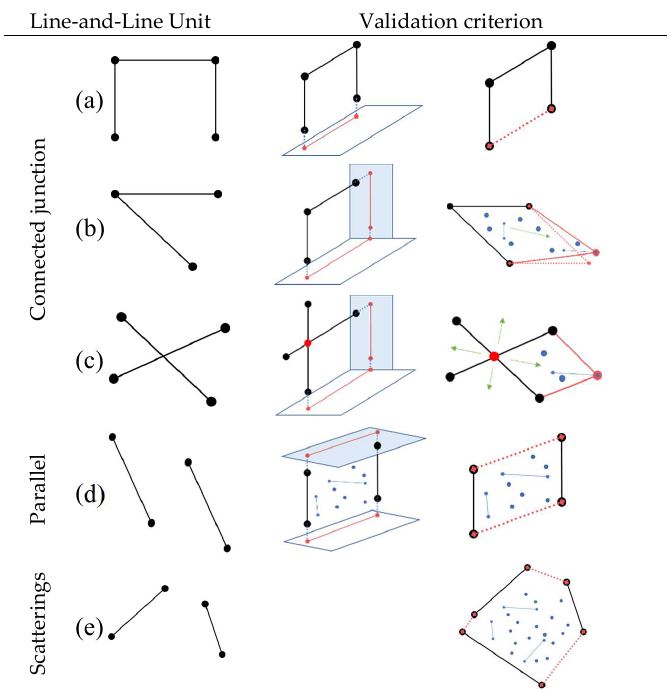
Figure 9. Validation criterions for Line-and-Line Unit.